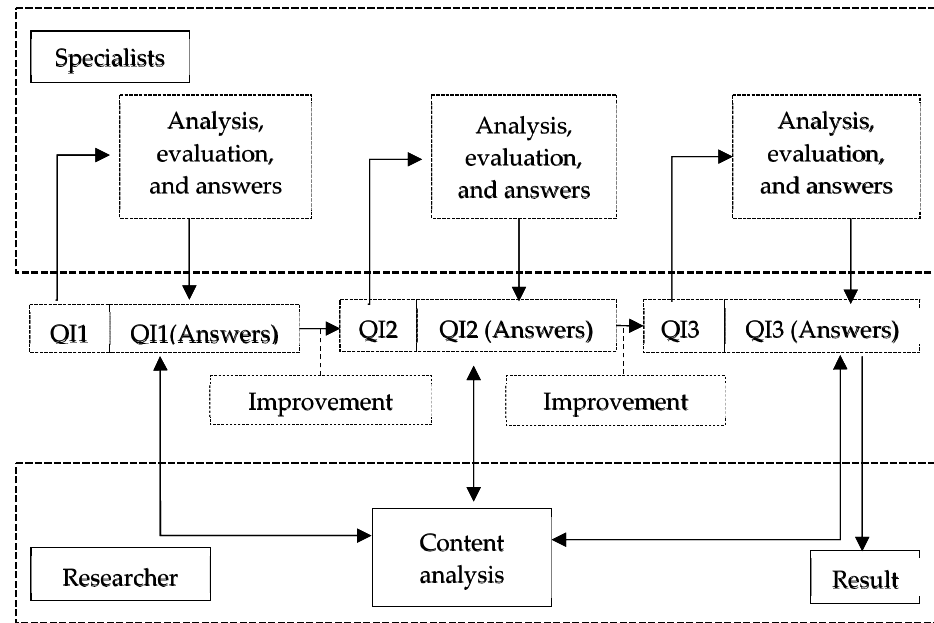
Figure 1. Structure of application and analysis of the Delphi method by experts.